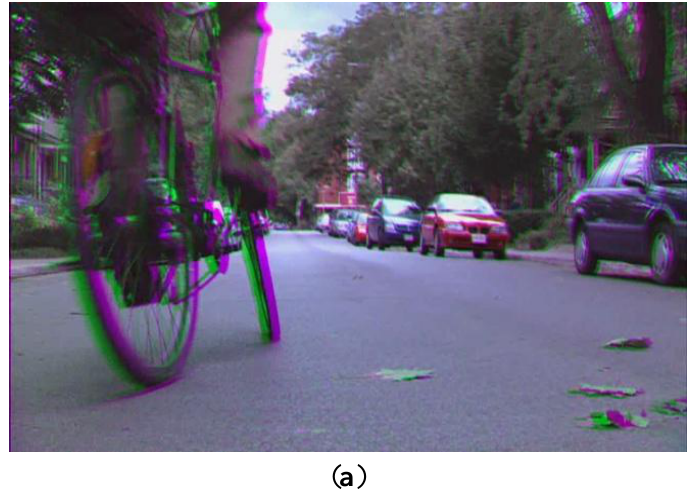
Figure 3. Examples of stereoscopic, left and right, disparity, and transformed images (where foveation model is applied): ( a ) original 3D stereoscopic (red-green) image; ( b ) left (green) and right (red) images of (a); including the foveation point as a red crosshair; ( c ) disparity image of (b) using the OpenCV library [21]; ( d ) transformed disparity image of (c) based on the foveation point of the red crosshair of (b) by the previous method [11]; ( e ) transformed disparity image of (c) based on the foveation point of the red crosshair of (b) by the proposed